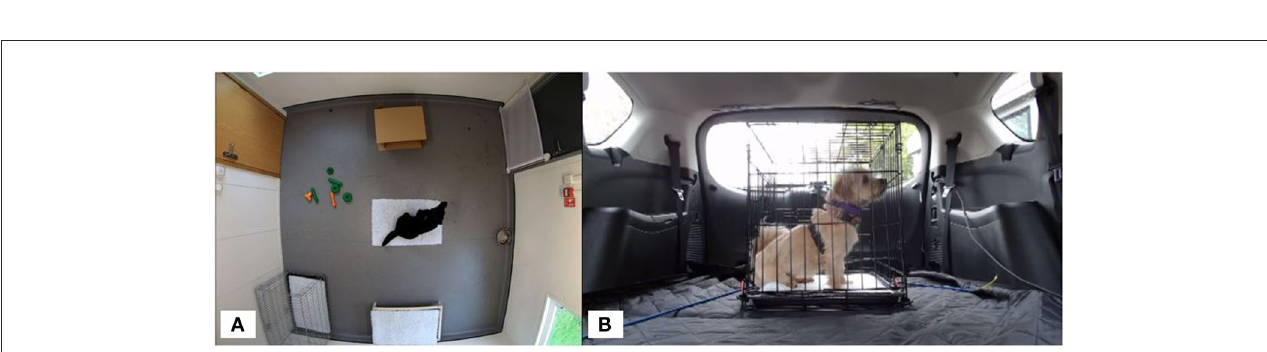
of the nose. Mean temperature readings were captured within each ellipse (46,